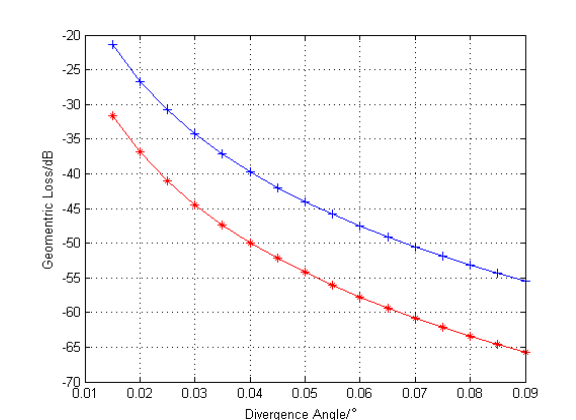
Figure 2. Geometric loss versus divergence angle Geometric loss is proportional to divergence angle,